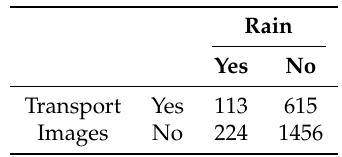
Table 2. Amount of hours in which transport or no transport was observed in the images, when U (cid:62) U Threshold , and its relationship with the presence or absence of rain during the same hour. Where U Threshold = 5 m/s corresponds to the minimum hourly wind speed at which transport was observed in the